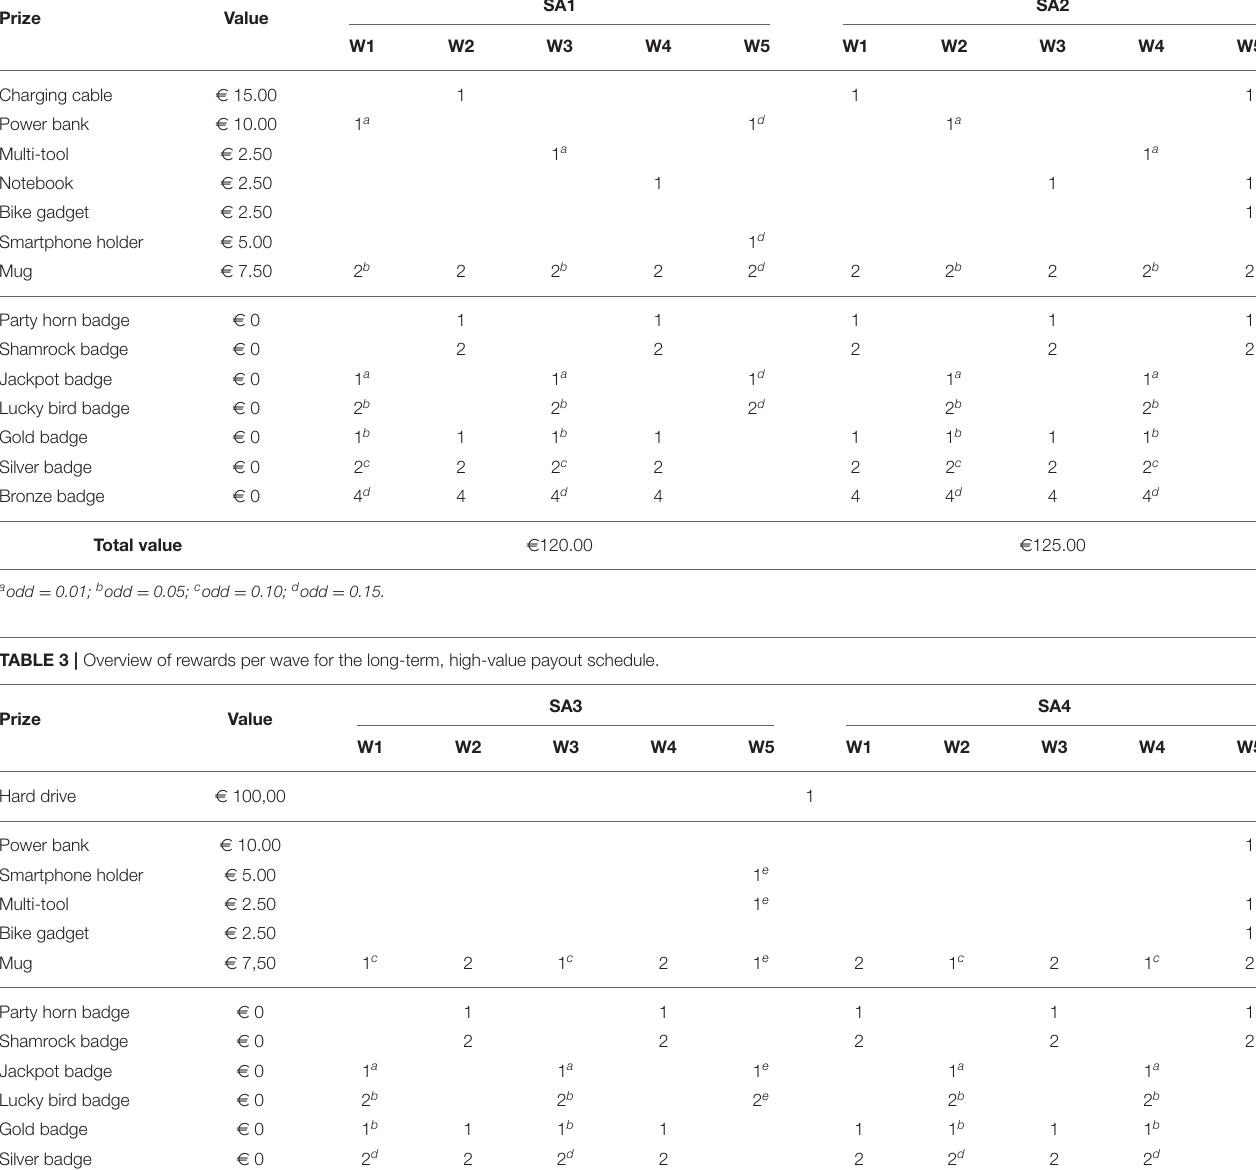
TABLE 2 | Overview of rewards per wave for the short-term, low-value payout schedule. Prize